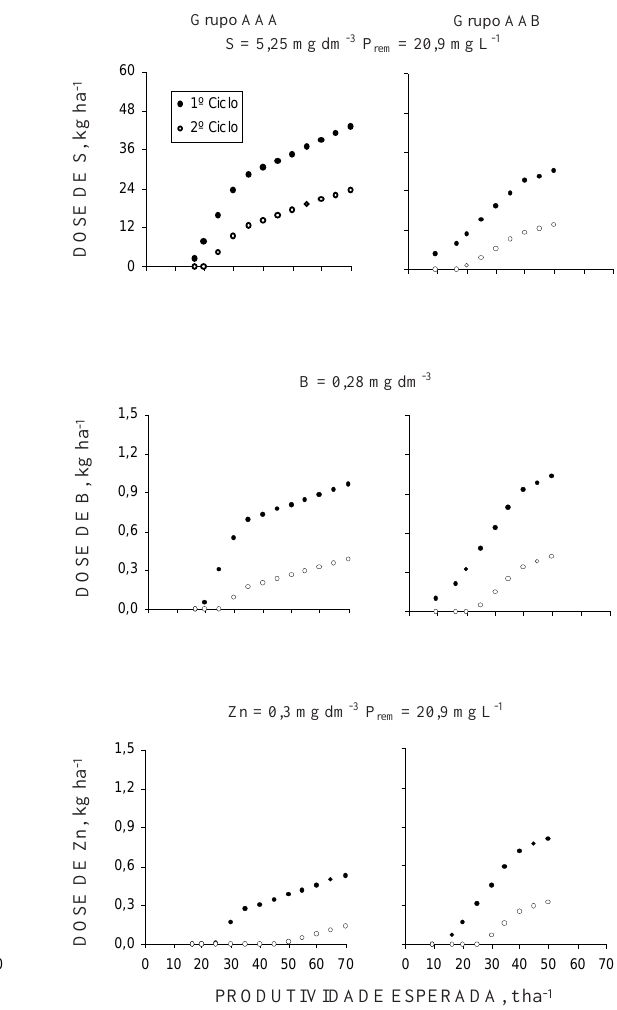
Figura 4. Doses de N, P O e K O recomendadas pelo 2 5 2 FERTICALC (cid:210)(cid:210)(cid:210)(cid:210)(cid:210) -Bananeira em função da produtividade esperada, para bananeiras dos grupos AAA e AAB, no primeiro e no segundo